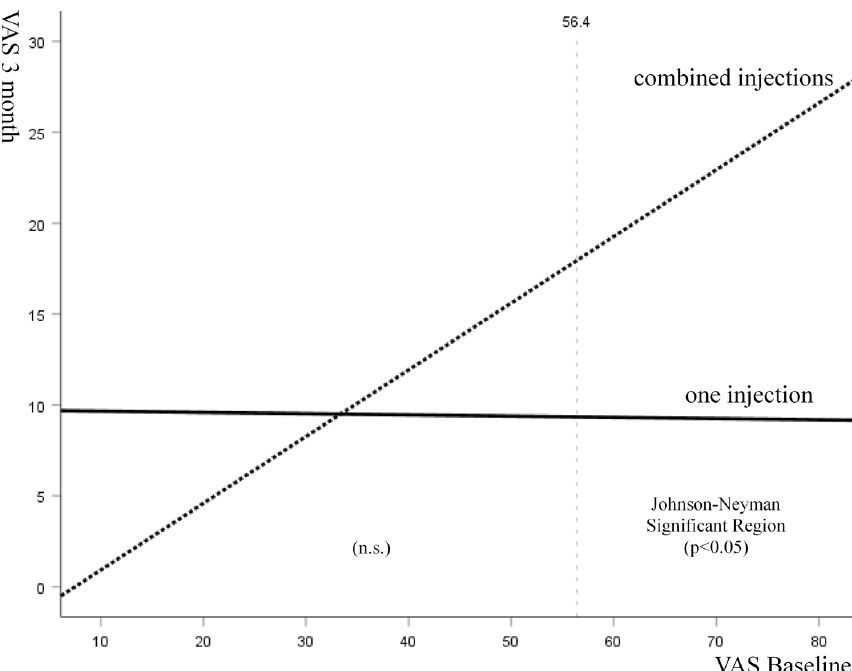
Figure 2. Graph showing that in patients with baseline VAS > 56.4 mm, those treated with one injection experienced a greater reduction in VAS pain than those treated with combined injections at 3-month